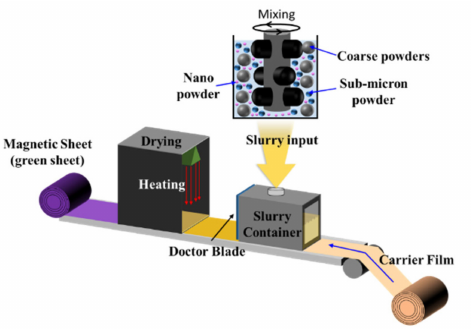
Figure 2. Schematic diagram of magnetic-sheet casting process for a power inductor.